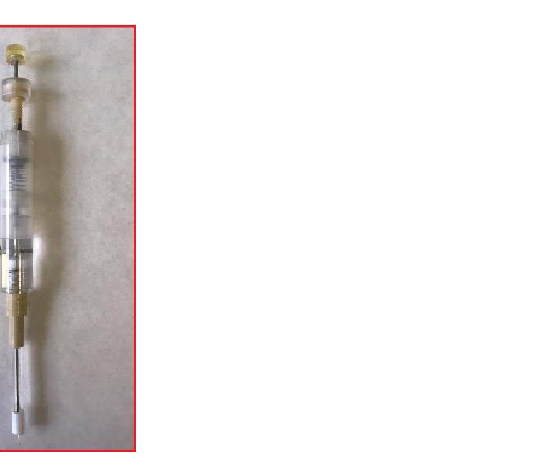
Figure 10. Three-electrode voltammetric cell with the centrally fixed working electrode (R–AgLAFE).